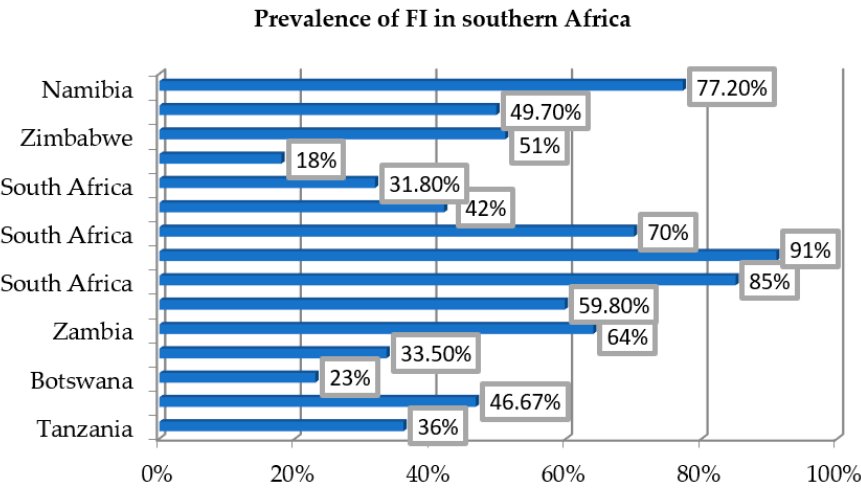
Figure 2. The prevalence of FI across southern African countries included in this systematic review.